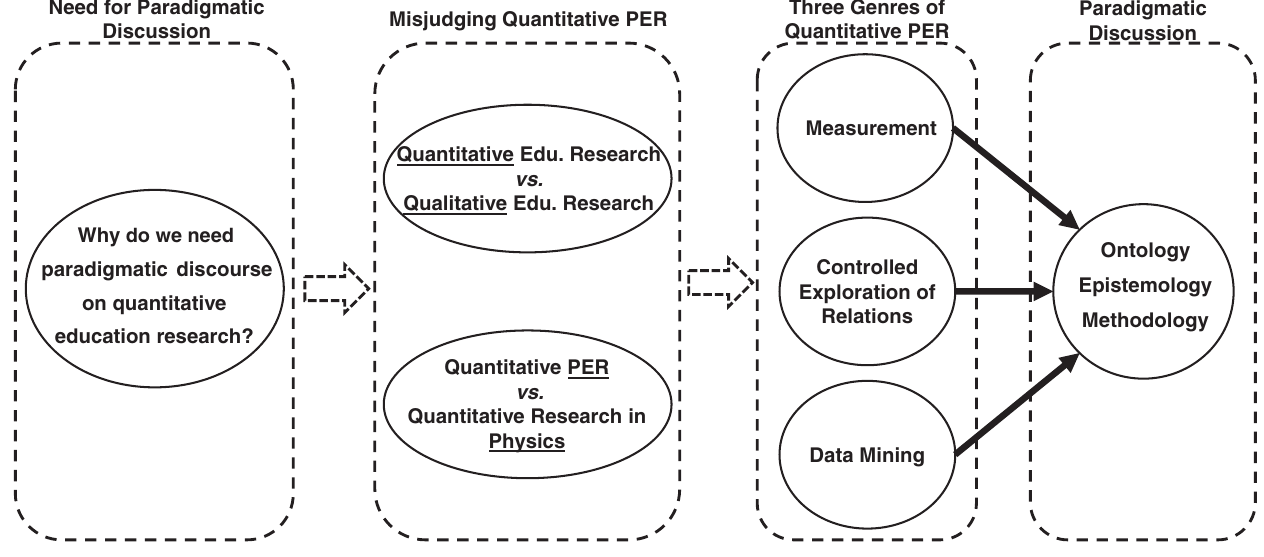
FIG. 1. Overall structure of paradigmatic analysis of quantitative (physics) education